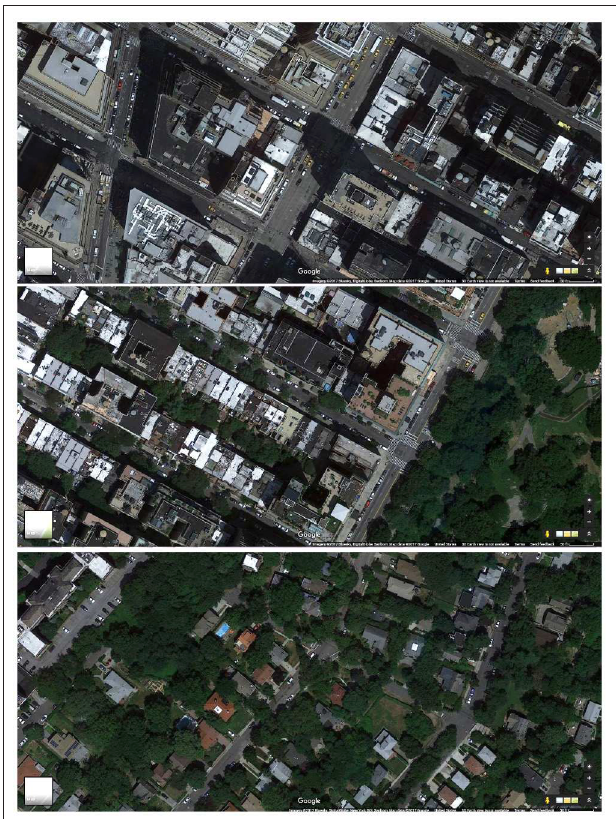
FIGURE 3 | Prototypical low (top), medium (middle) and high (bottom) nearby nature in the New York City area (Imagery: © 2017 Bluesky, DigitalGlobe, New York GIS, Sanborn, Map data: © 2017 Google, used under